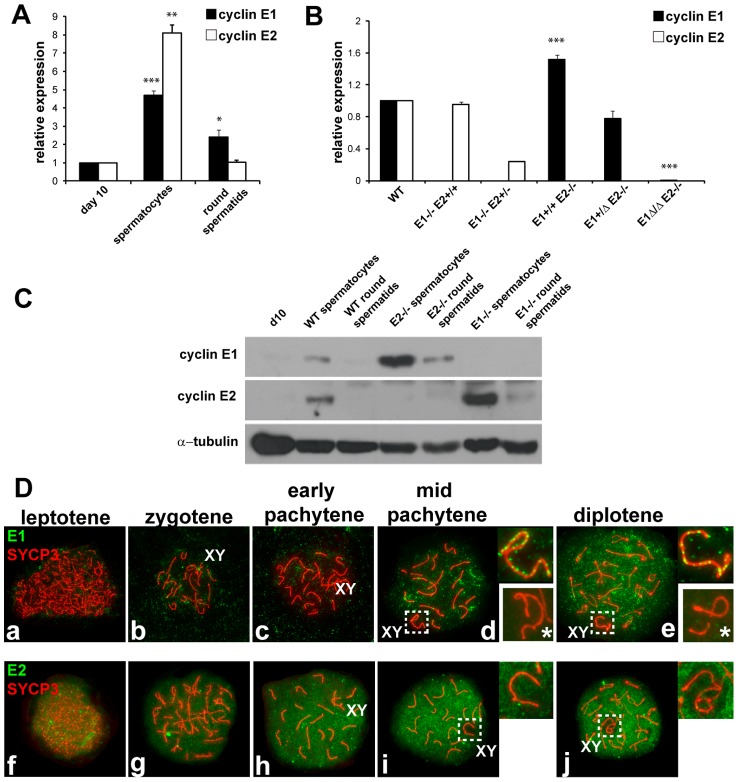
Cyclin E1 and E2 have differential mRNA and protein expression patterns during spermatogenesis.(A) Relative mRNA expression (compared to the expression of Arbp and normalized to expression levels obtained from pnd10 testes) was determined using RT-qPCR in pnd 10 testes and in purified populations of pachytene spermatocytes and round spermatids. Results are the mean ± SEM of four independent experiments. *p<0.05, **p<0.01, ***p<0.001. (B) Relative E1 and E2 mRNA expression (compared to the expression of Arbp and normalized to expression levels obtained from WT testes) using RT-qPCR of whole adult testes of different genotypes. Results are the mean ± SEM of three independent experiments. ***p<0.001. (C) Immunoblot analysis of E1 and E2 protein expression from tissues or purified populations of cells as noted. Immunodetection of α-tubulin was used as the loading control. (D) Localization of E1 (a–e) or E2 (f–j) (green) and SYCP3 (red) during prophase I in WT spermatocyte spreads. Right upper insets show the X and Y chromosomes (XY) outlined in d, e, i and j. E1 and E2 are totally absent in the XY of E1−/−E2+/+ spermatocytes (lower right insets with asterisk in d,e).